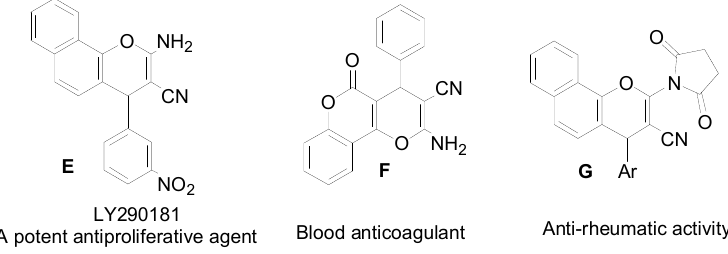
Figure 2. Structures of benzochromenes with diverse biological and pharmacological activities.